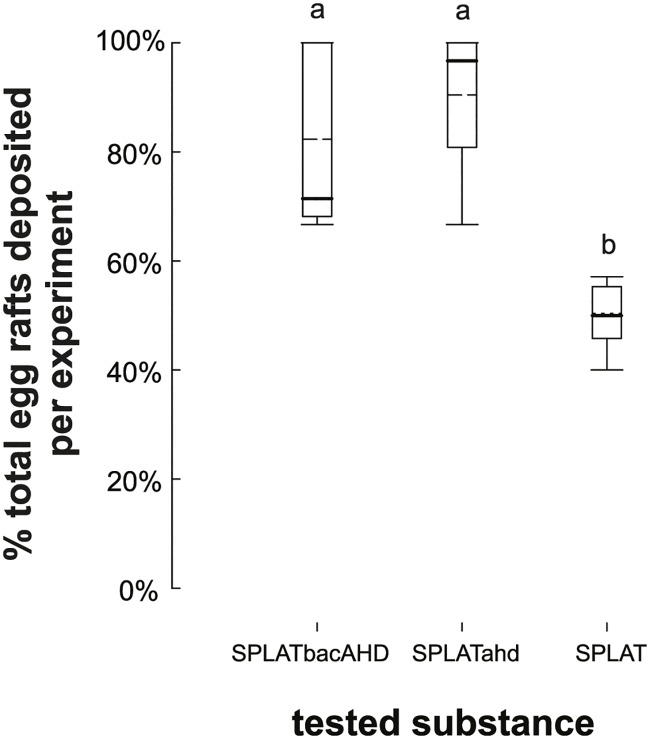
Proportion of Cx. quinquefasciatus egg rafts laid in treatment (SPLATbacAHD, SPLATahd) compared to control (SPLATblank).Box plots with both medians (bold lines) and means (dotted lines) are shown. Same letters indicate that treatments did not differ significantly (p < 0.05) from each other (Tukey pairwise comparisons after ANOVA).